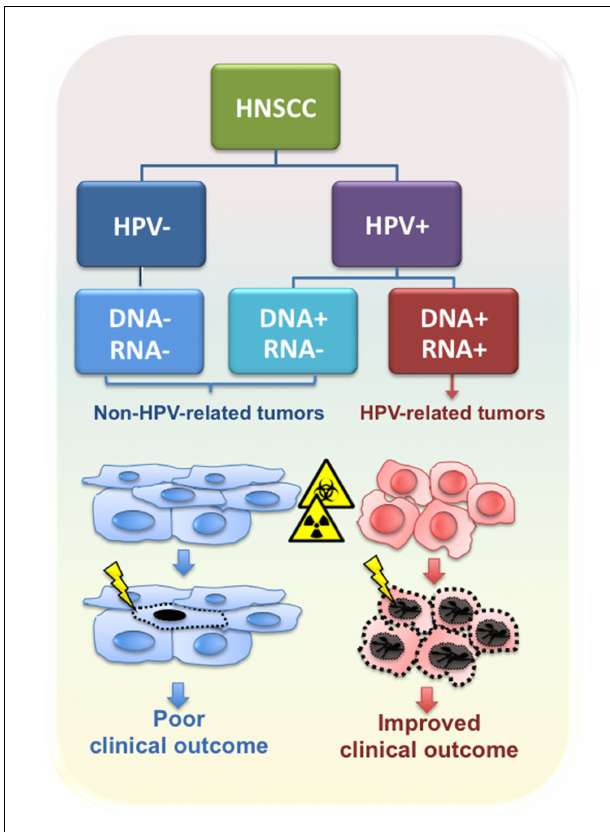
FIGURE 1 | Classification of HNSCC according to HPV tumor status. HPV-related tumors are distinct from non-HPV-related tumors in biological and clinical features, including response to radio- and chemotherapy and clinical outcome.